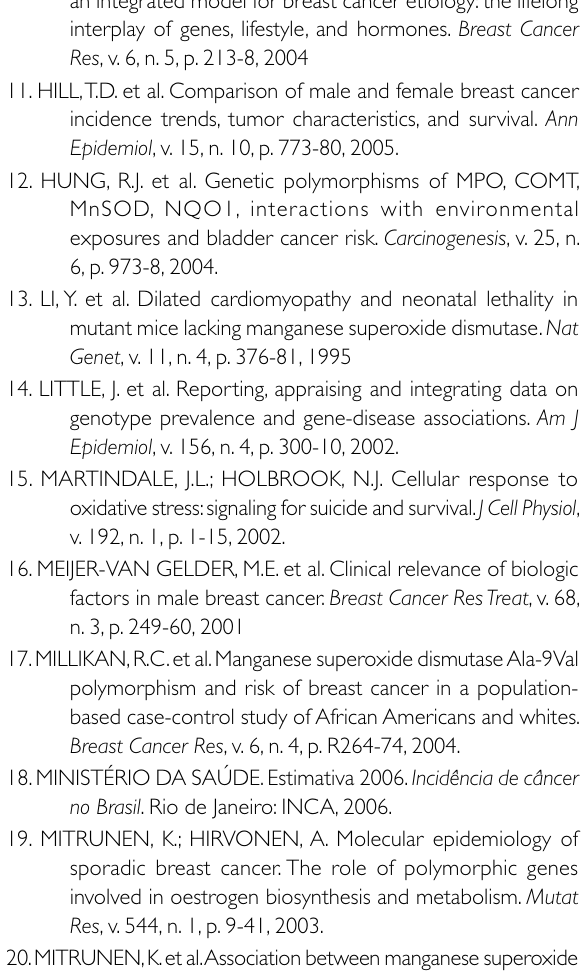
an integrated model for breast cancer etiology: the lifelong interplay of genes, lifestyle, and hormones. Breast